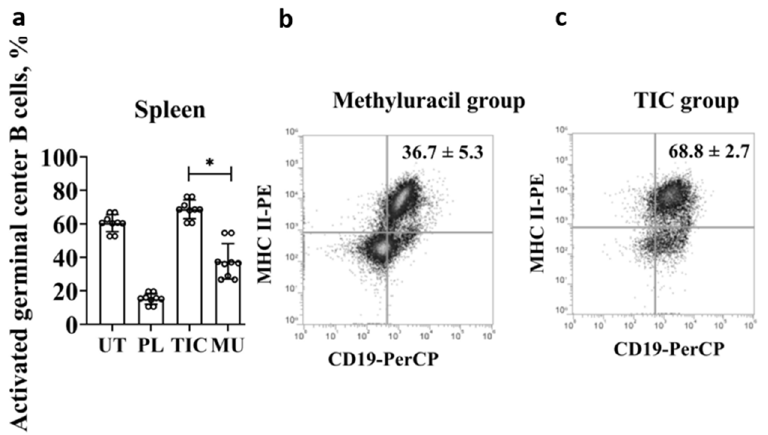
Figure 4. Results of flow cytometric phenotypic analysis of activated germinal center B cells. ( a ) The average level of activated germinal center B cells (B220/CD45R + (APC)CD19 + (PerCP)CD40 + (PE)MHCII + (PE)CD43 + (PE)) in the spleen. ( b ) The average level of activated germinal cen- ter B cells (B220/CD45R + (APC)CD19 + (PerCP)CD40 + (PE)MHCII + (PE)CD43 + (PE)) in the methy- luracil group. ( c ) The average level of activated germinal center B cells (B220/CD45R + (APC)CD19 + (PerCP)CD40 + (PE)MHCII + (PE)CD43 + (PE)) in the TIC group. UT—untreated group, PL—placebo group, TIC—TIC group, MU—methyluracil group. The data are shown as mean value (M) ± standard deviation (SD) ( n = 6